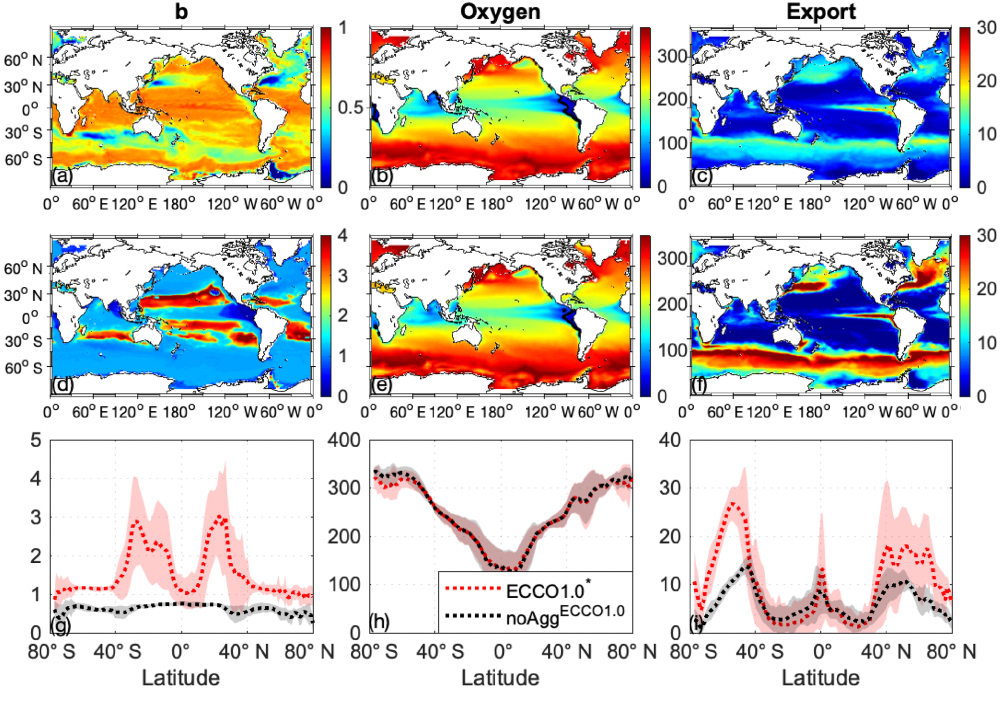
Figure 1. Global maps of b (a, d) , O 2 at 100m (mmolm − 2 , b, e ) and export at 100m (mmolPm − 2 a − 1 , c, f ) for noAgg ECCO1 . 0 (a, b, c) and for the best aggregation model with regard to the sum of J RMSE and J OMZ (simulation no. 26; d, e, f ). The black line indicates the OMZ for a criterion of 50mmolm − 3 . Lower panels: Global mean (dotted line) and standard deviation (transparent shaded) of b (g) , O 2 (h) and export (i) of noAgg ECCO1 . 0 (black) and the best aggregation model with regard to the sum of J RMSE and J OMZ (simulation no. 26; red). Please note the different scaling for b values (a, d) .